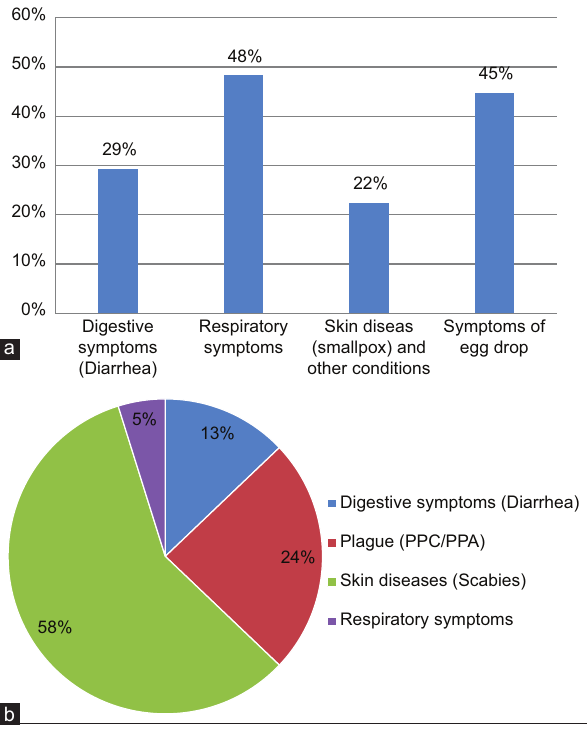
[Figure 1: Frequent disease symptoms or health problems mentioned by farmers in (a) poultry farms and (b) pig